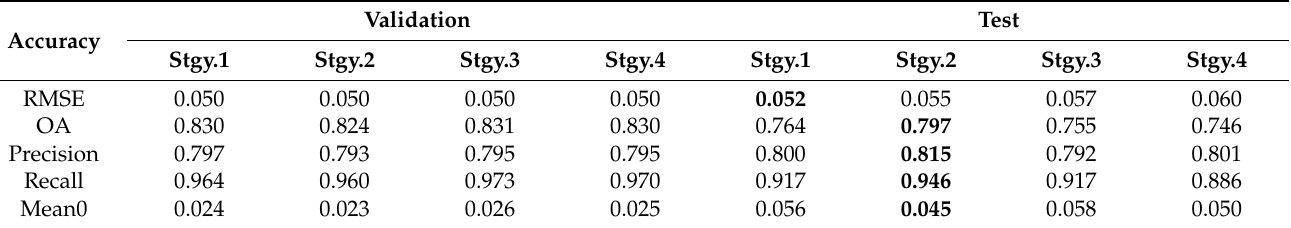
Table 4. The average of validation accuracy and test accuracy of four mapping strategies.